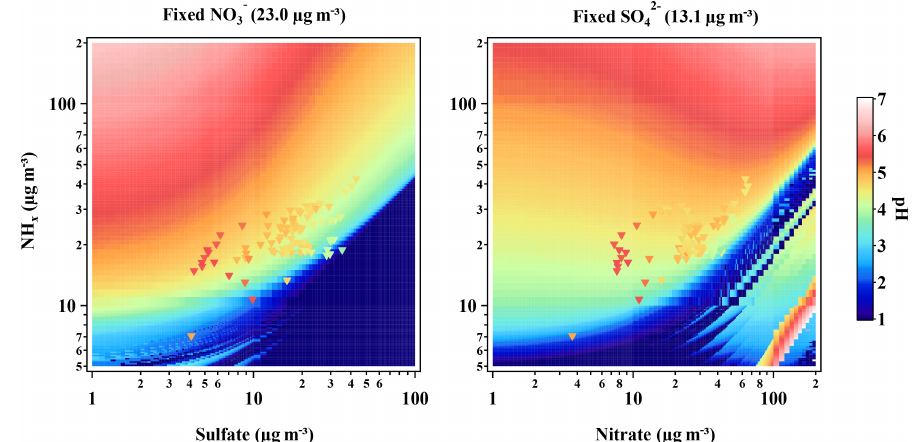
Figure 11. Sensitivity tests of pH’s response to sulfate or nitrate change with inputting the given NH x , simulated by ISORROPIA II. Field measurement data (triangles) were drawn upon the simulation data and colored with predicted pH, respectively. The simulation is conducted with fixed RH (58%) and temperature (273.15K).